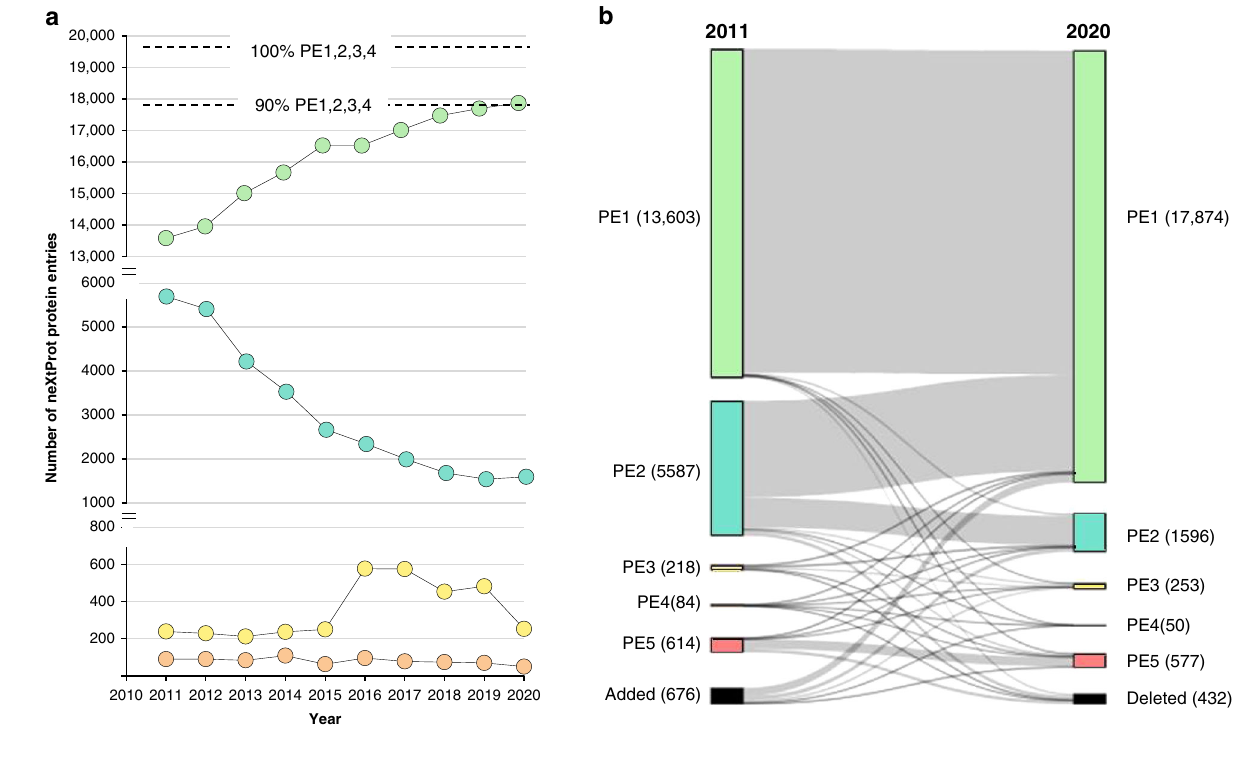
Fig. 2 Completing >90% of the high-stringency human proteome. a Annual neXtProt HPP evidence of protein existence (PE1,2,3,4,5) metrics from 2010 to 2020. This data demonstrates a strong and progressive increase in PE1 identi fi cations across the decade (13,588 in 2011 to 17,874 in 2020), correlative equivalent decrease in PE2 (5,696 to 1596), a post-2015 rise in PE3 coincident with revised guideline implementation (239 to 253) and decrease in PE4 identi fi cations (90 down to 50). PMS Pantone colours employed match in the fi gure match for all past annual neXtProt HPP KB reference PE1,2,3,4,5 data release colours, namely PE1: light green, PE2: teal, PE3: yellow, PE4: orange, and PE5: red). b Decadal Sankey diagram of changes in PE1,2,3,4,5 status